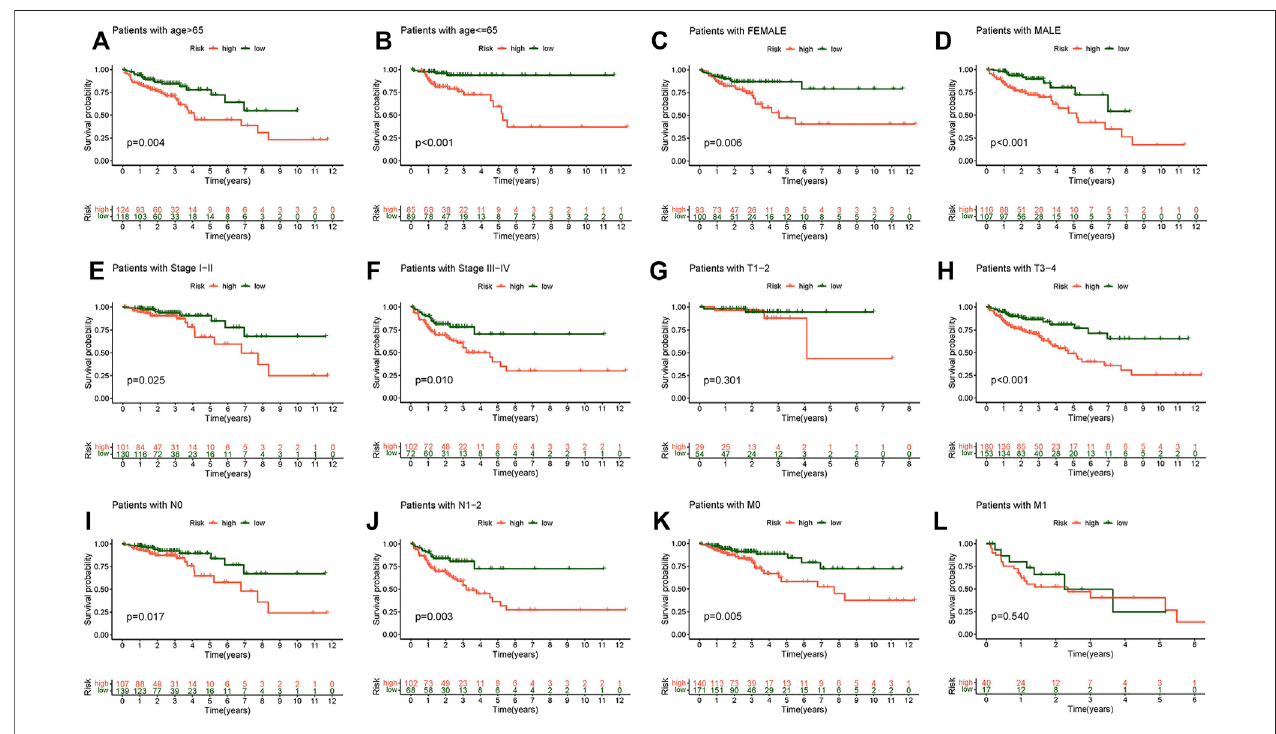
FIGURE6| Kaplan – Meiersurvivalsubgroupanalysisfordifferentialclinicopathologicalfeaturesinthehigh-andlow-riskscoregroup. (A) Patientswithage > 65. (B) Patients with age ≤ 65. (C) Female patients. (D) Male patients. (E) Patients with stages I-II. (F) Patients with stages III-IV. (G) Patients with stages T1-2. (H) Patients with stages T3-4. (I) Patients with stage N0. (J) Patients with stages N1-2. (K) Patients with stage M0. (L) Patients with stage